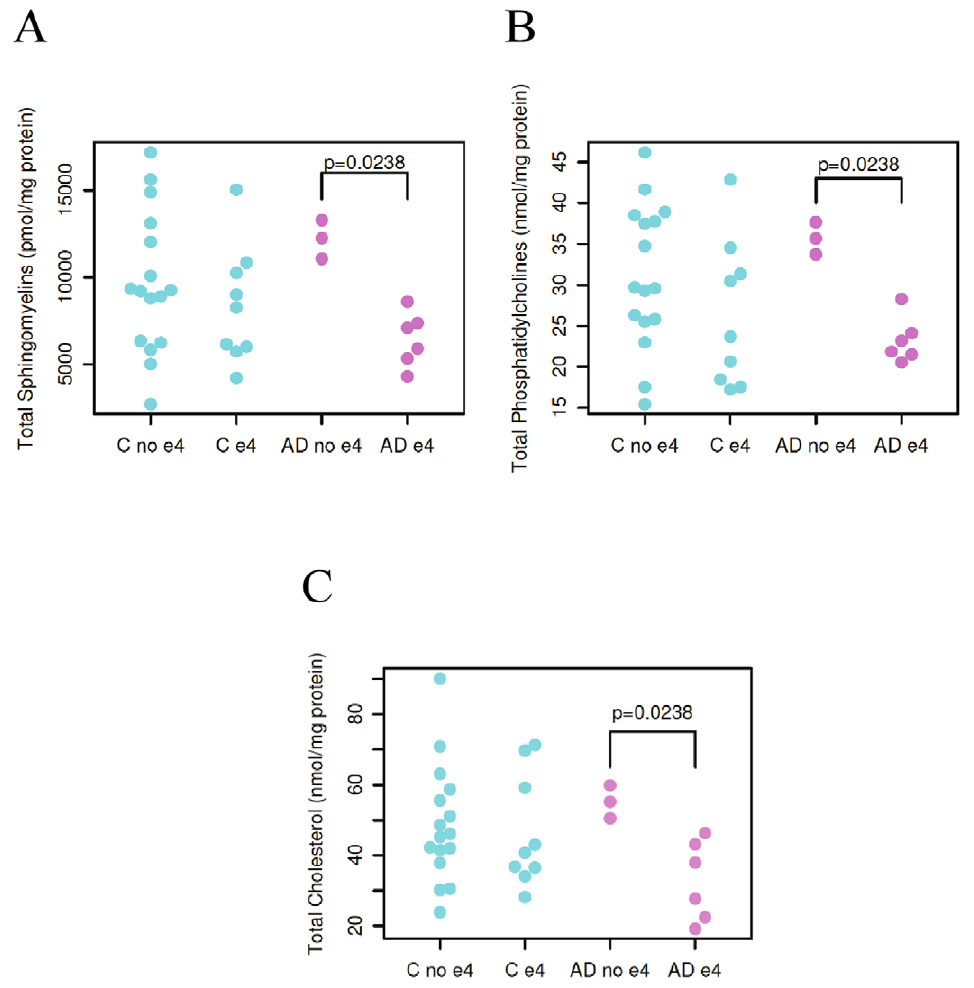
Figure 9. ApoE4 carriers with AD have significantly lower mass levels of sphingomyelin (panel A), phosphatidylcholine (panel B), and cholesterol (panel C) (p=0.0238 for both lipid classes by Wilcoxon rank sum tests, two-sided).